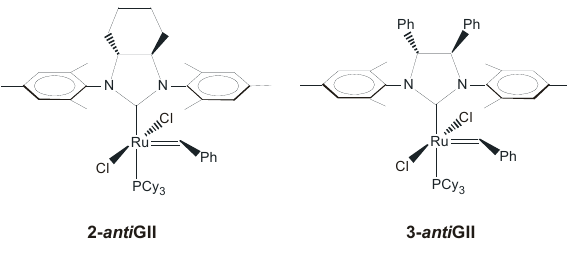
Figure 3. Catalysts with anti NHC backbone.